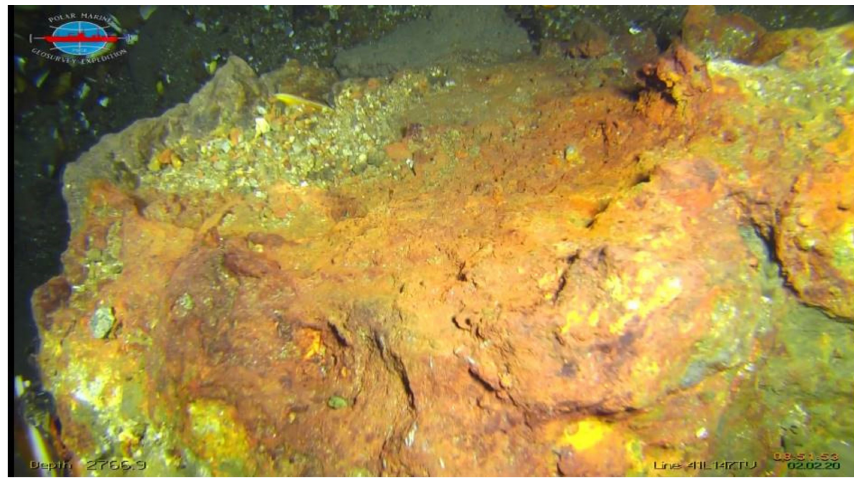
Figure 12. Hydrothermal crusts of iron hydroxides and oxidized sulfide ores. Koralovoye field.